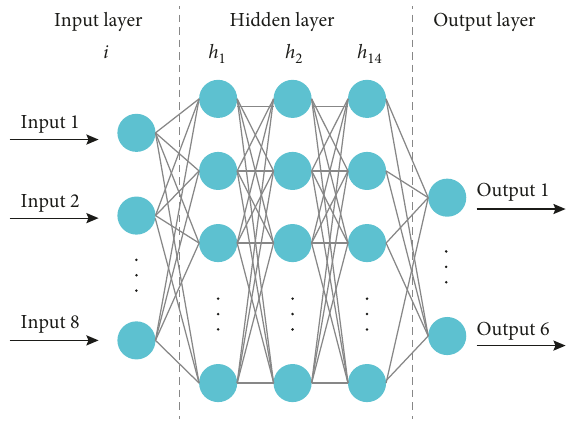
Figure 1: The structure of